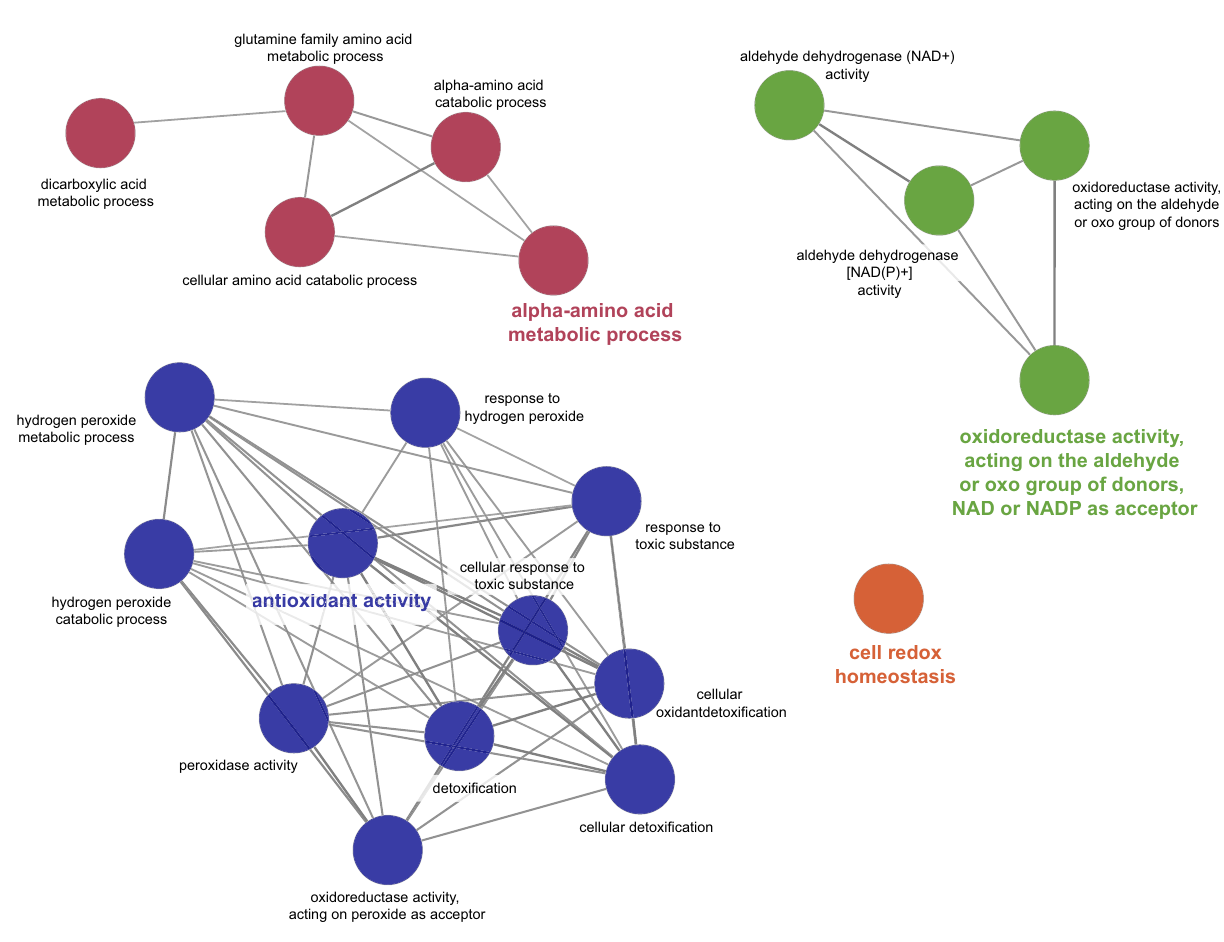
Figure 1. Functional classification of differentially ( P < 0.05) expressed proteins in the liver of HMU and LMU cows based on Gene ontology biological processes using ClueGO software (version 3.8.0; Cytoscape Software; https:// cytos cape.